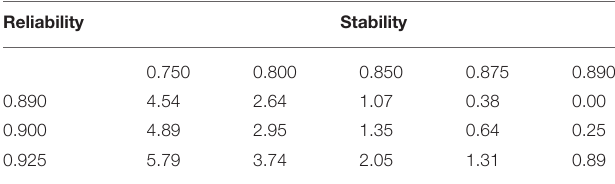
TABLE 1 | Slope variance as a function of reliability and